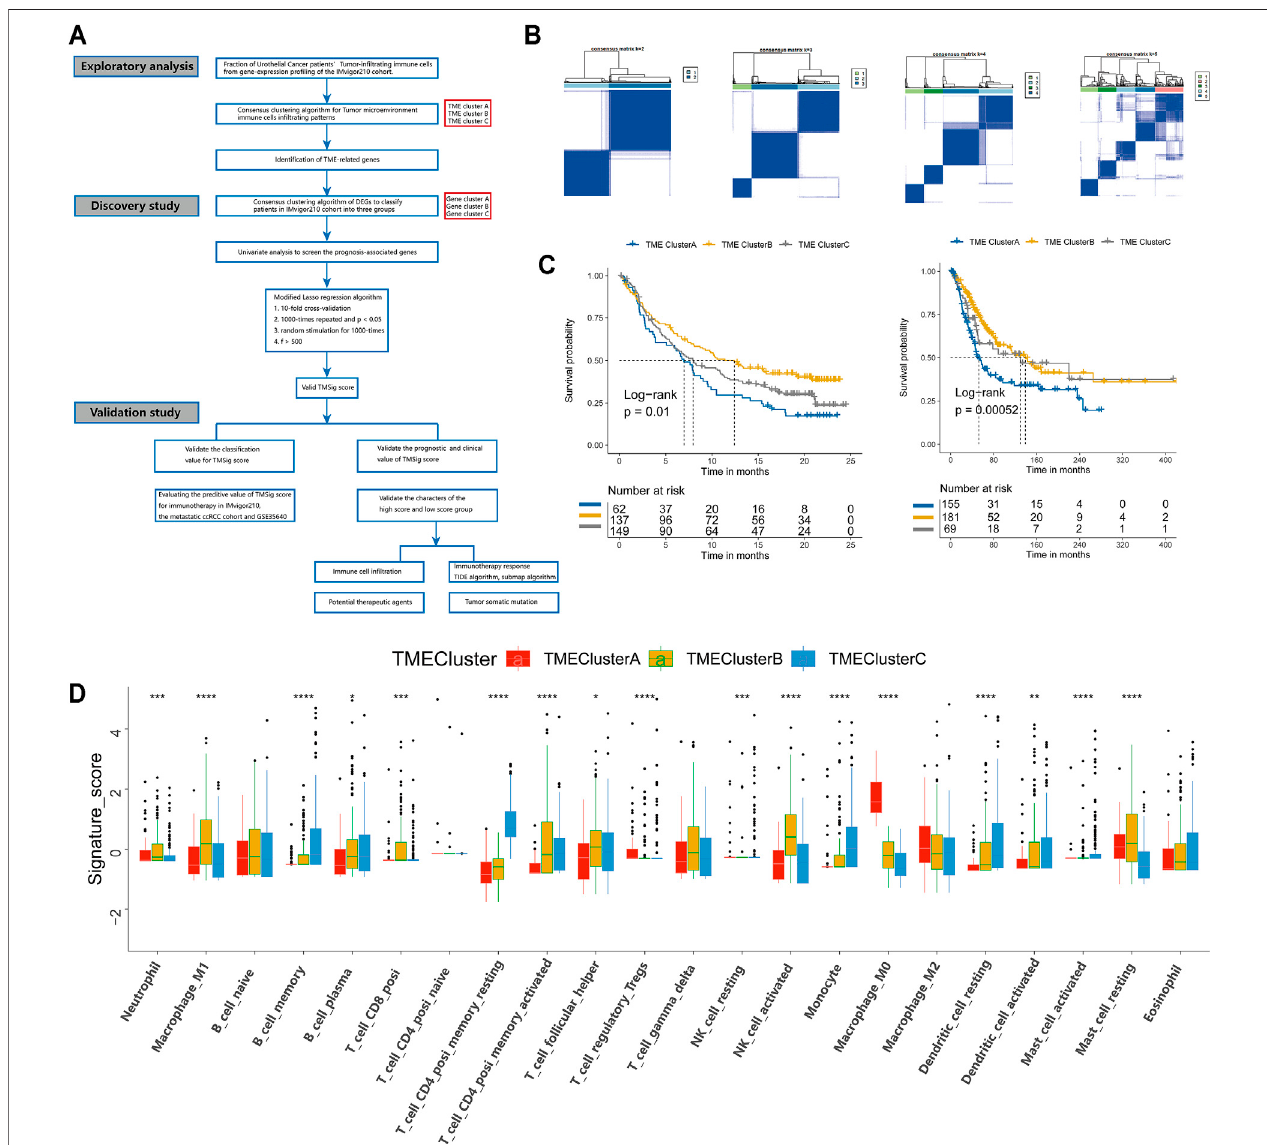
FIGURE 1 | Landscape of the TME in urothelial cancer and characteristics of TME subtypes. (A) The overview of study design. (B) Consensus matrixes of all patients with urothelial cancer for each k (k (cid:1) 2 – 5), displaying the clustering stability using 1,000 iterations of hierarchical clustering. (C) Kaplan-Meier curves for overall survival(OS)ofurothelialcancerpatientsfromtheIMvigor210cohortwiththeTMEpatterns. (D) Immunein fi ltrationcellsexpressedinTMEclusters.Therangeof p values are labeled above each boxplot with asterisks (* p < 0.05, ** p < 0.01, *** p < 0.001, **** p < 0.0001). (E) Kaplan Meier curves for overall survival (OS) of urothelial cancer patients from the TCGA cohort with the TME